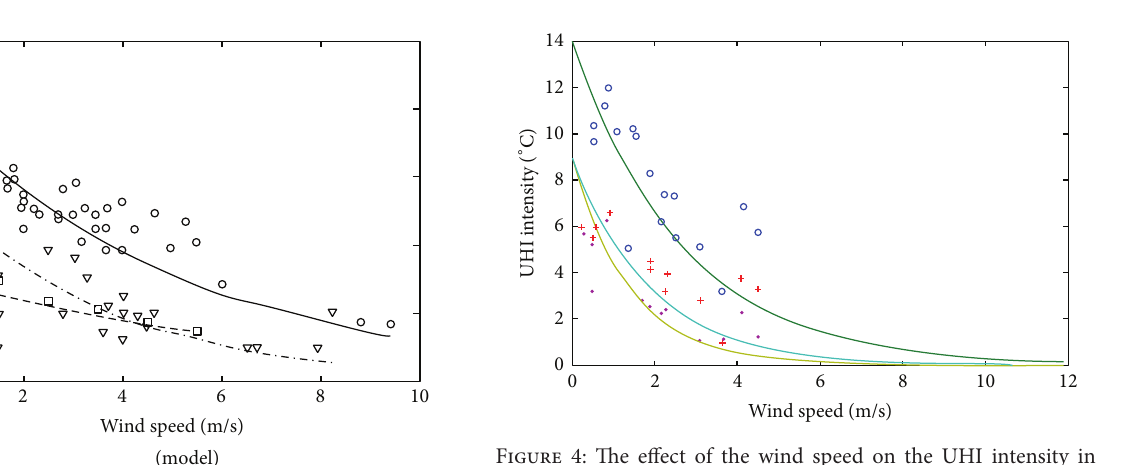
Figure 4: The effect of the wind speed on the UHI intensity in Chambly, Marieville, St. Basile-Le Grand, St. Cesaire, St. Pie, Ste. Angele-de Monnoir, and Ste. Madeline. Symbols represent data as reported by Oke [9], while the theoretical lines are obtained from